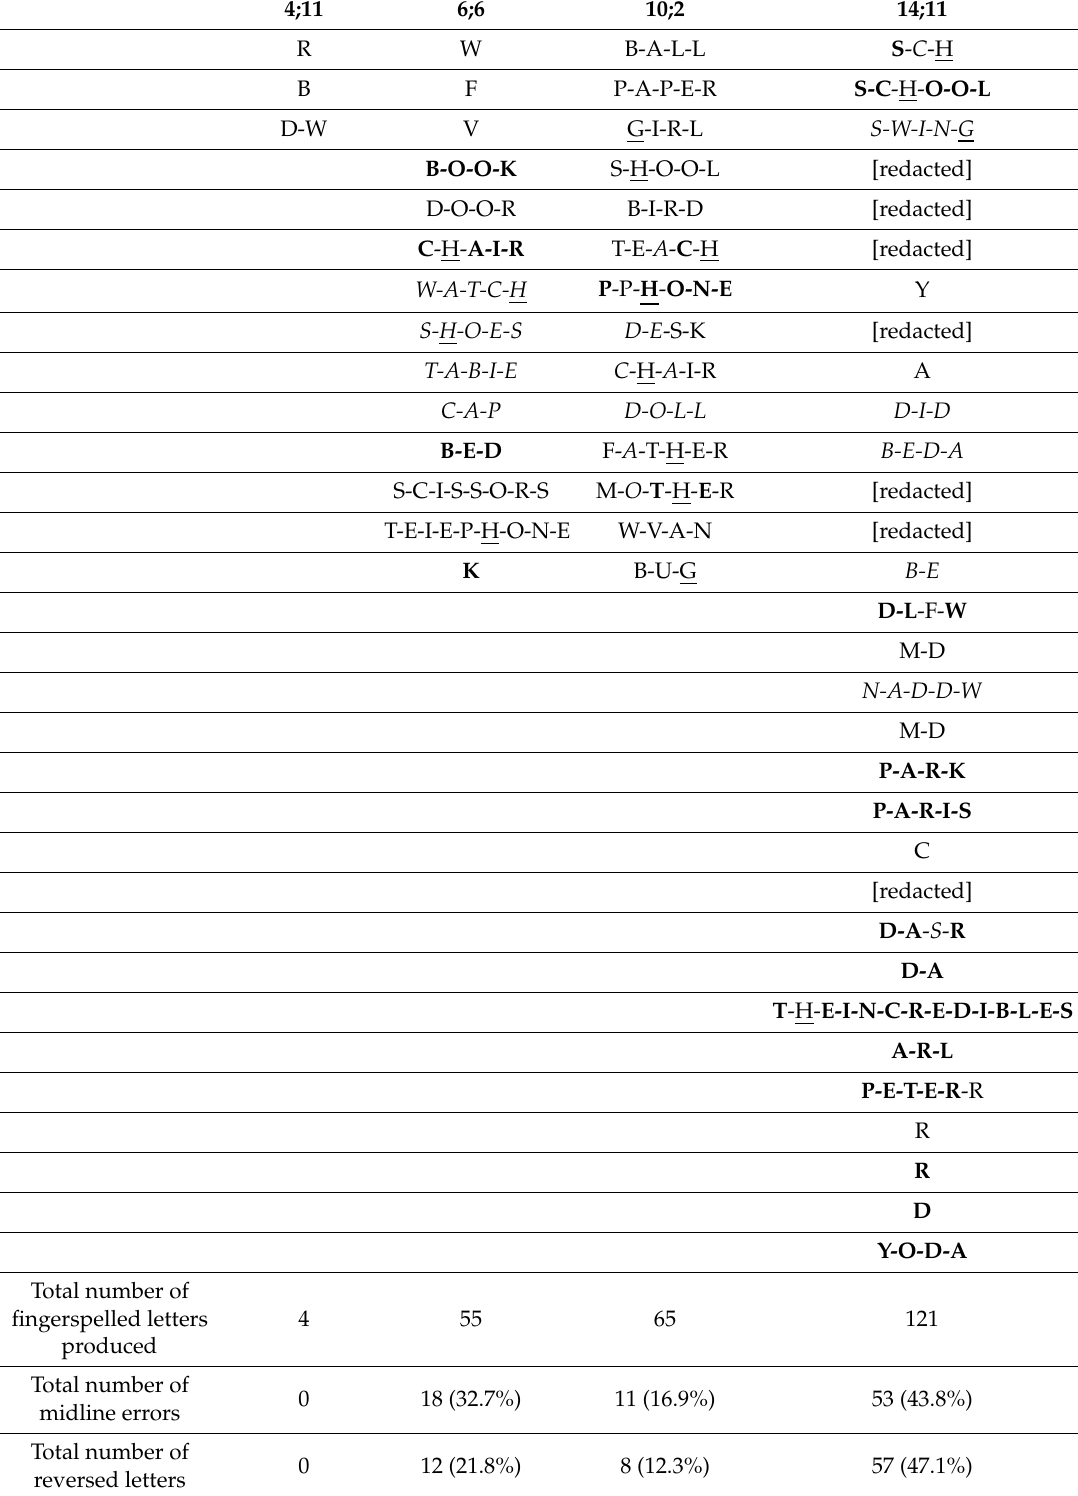
Table 5. Fingerspelled letters produced at each age. Letters produced with correct outward palm orientation (all letters except g , h ) are represented in plain font, letters produced with correct inward palm orientation ( g , h ) are underlined, while letters that exhibited 180-degree reversals are bolded and letters produced with midline errors are italicized. Some tokens contain spelling errors produced by the child, e.g., the substitution of i for l